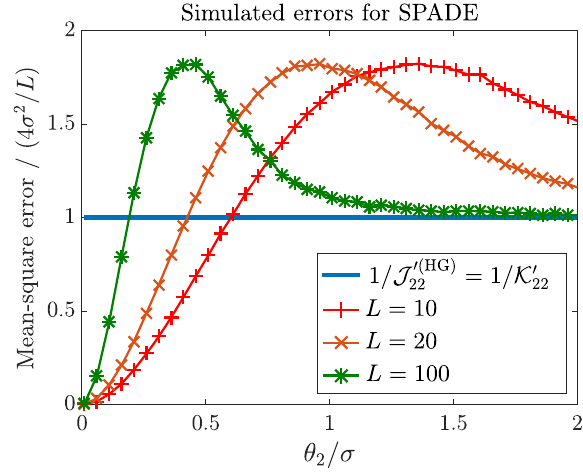
FIG. 13. Cramér-Rao bounds on the mean-square error of estimating X 1 or X 2 for a 50-50 hybrid scheme (solid line) and direct imaging (dash-dotted line). Note that the log-log scale is used here for clarity, unlike all the other plots in this paper. The vertical axis is normalized with respect to the error of locating an isolated source with direct imaging.